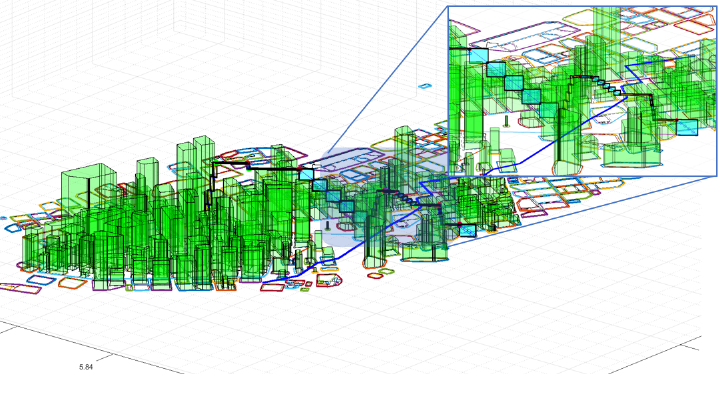
Figure 22. Example of a 3-D geofence wrapping a “constant cruise altitude” flight plan for sUAS 2 . The sUAS 2 trajectory is shown in black, and the sUAS 1 trajectory is shown in blue. Polyhedra (green) denote keep-out geofences around buildings. The remaining 2-D polygons denote keep-out geofences around buildings that are outside the combined ROI.